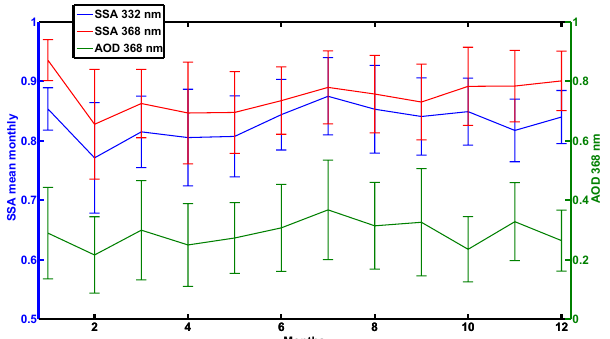
Figure 9. Mean monthly SSAs (left axis) in the UV (UVMFR) at two wavelengths and AOD at 368nm from the UVMFR (right axis) for the whole 5-year period in Athens. Error bars represent 1 stan- dard deviation of the mean.